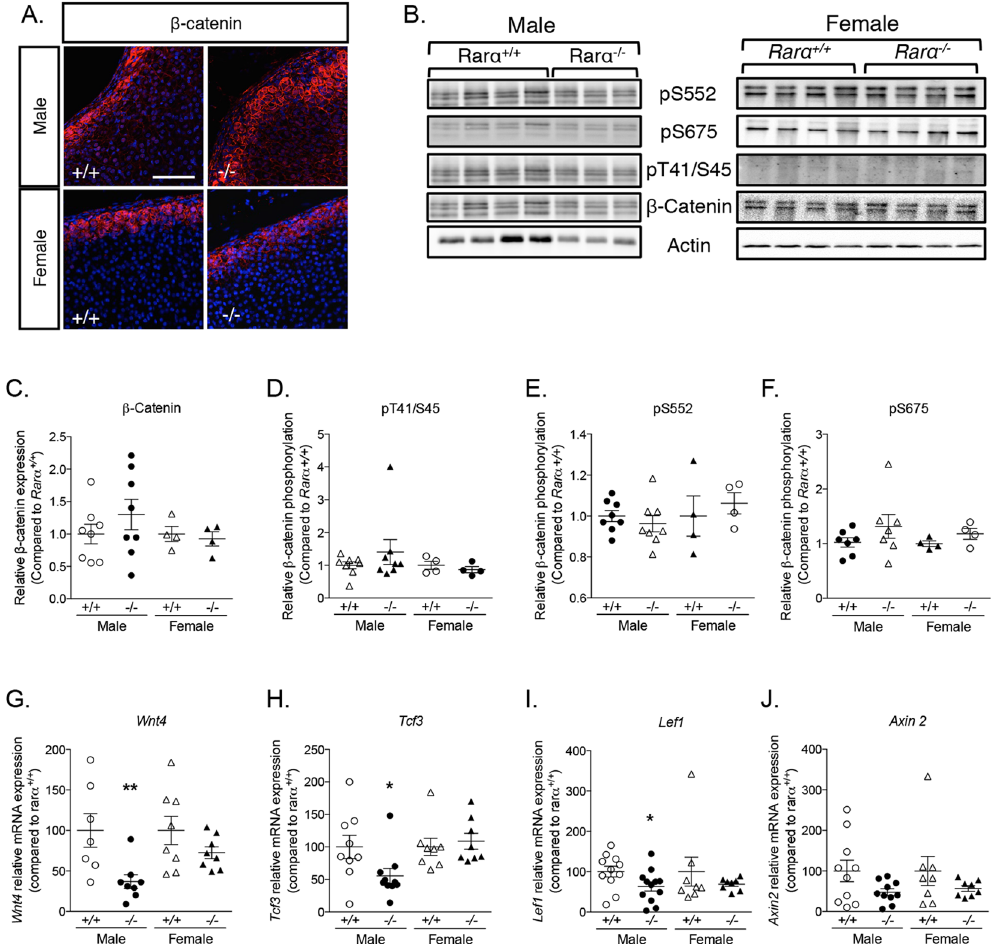
Figure 5. Rar α inactivation alters Wnt signaling pathway in 12 weeks old male mice. ( A ) Expression of β -catenin was evaluated by immunofluorescence in 12 weeks old male and female Rar α + / + and Rar α - / - mice. ( B ) Expression and phosphorylation of β -catenin in response to Rar α invalidation. Proteins were extracted from total adrenal and submitted to western blot analysis. Phosphorylation/dephosphorylation in activating (pS552 and pS675) and inactivating (pT41/S45) residues and total expression of β -catenin was investigated. ( C – F ) Quantification of β -catenin expression ( C ) and of phospho-specific signals in inactivating ( D ) and activating ( E , F ) residues was performed in Rar α + / + and Rar α - / - adrenal. (G-J) The expression of Wnt4 ( G ), Tcf3 (H), Lef1 ( I ) and Axin2 ( J ) was investigated by RT-qPCR on mRNA extracted from 6 to 11 adrenals from Rar α + / + and Rar α - / - male and female mice. Values are presented as mean ± SEM; p values were calculated using a Mann- Whitney test or t -test. * p < 0.05; ** p <